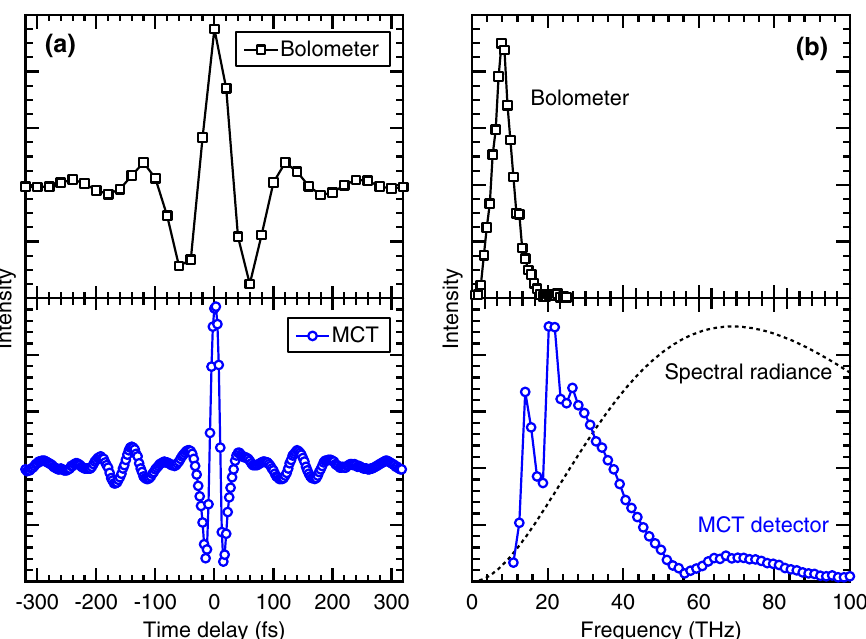
FIG. 3. (a) Interferograms and (b) frequency spectra obtained from measurements of the infrared light source by the bolometer (square) and the MCT detector (circle) with factors and offsets. The spectral radiance of Planck ’ s law at 1173 K (dashed line) was also plotted against frequency alongside experimental values. The spectral radiance was used for calculating the frequency sensitivity given by Eq.